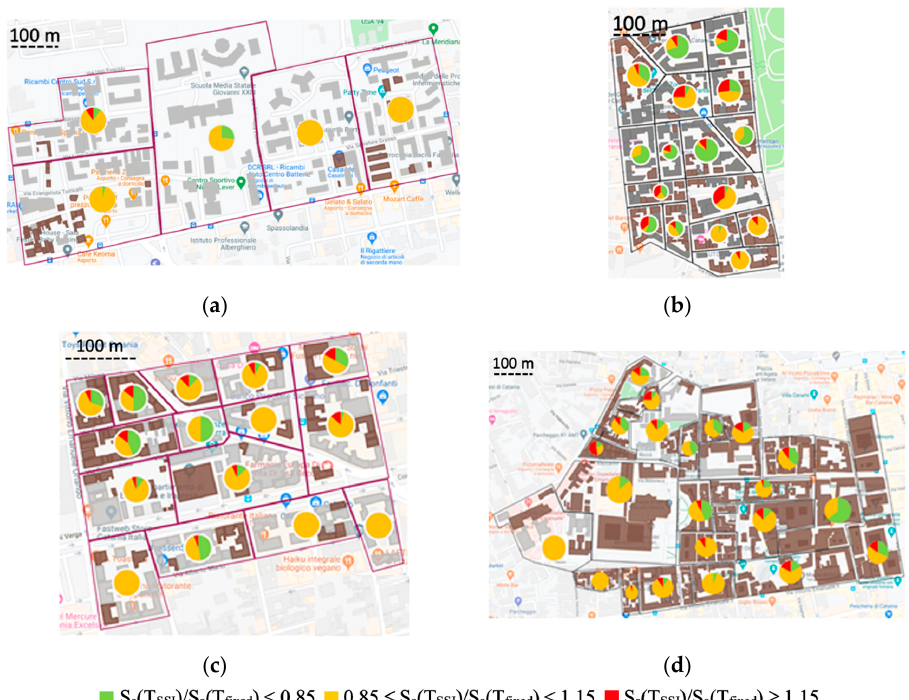
Figure 11. Spatial distribution of S a ( T SSI )/S a ( T fixed ) ratios for the 1990 seismic input: ( a ) west area; ( b ) northeast area; ( c ) north Old Town; ( d ) south Old Town.